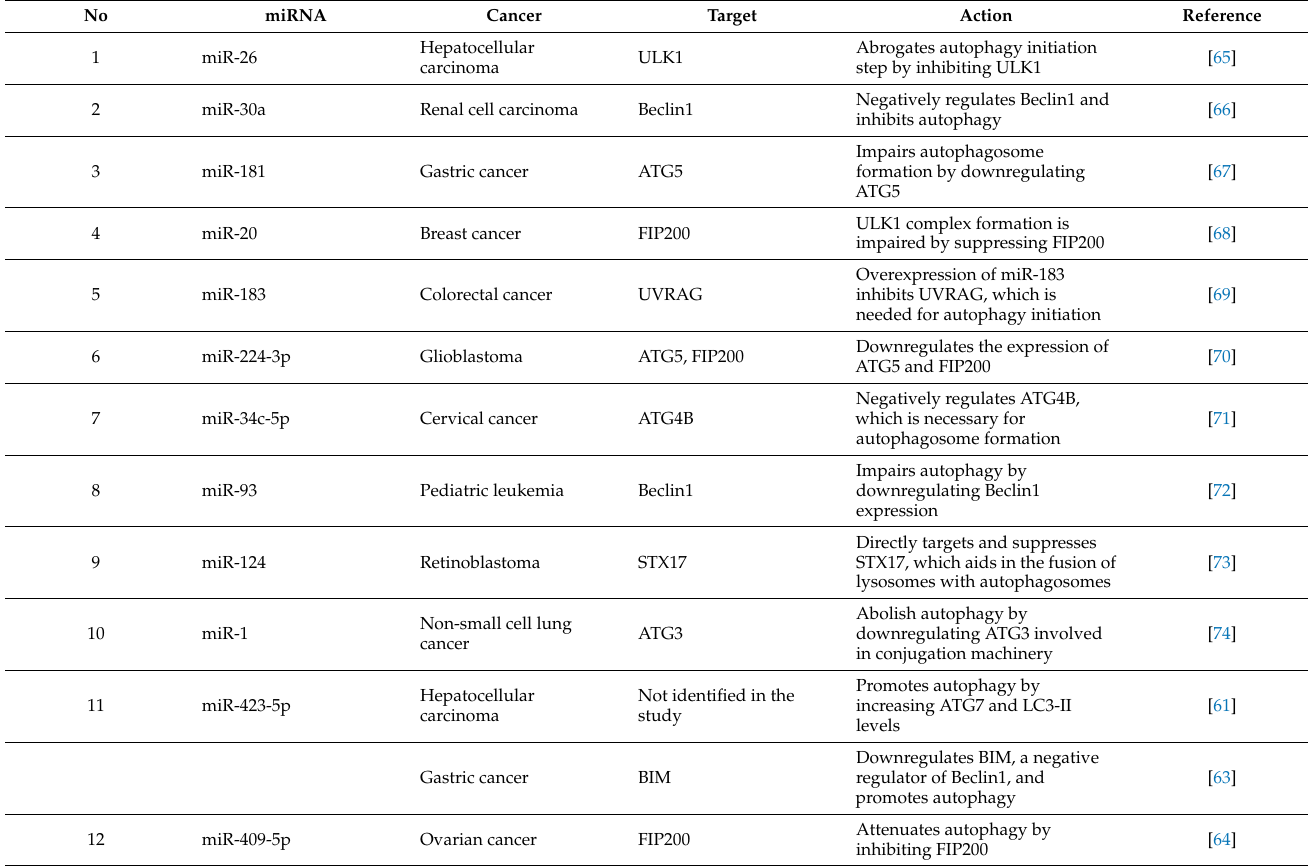
Table 3. The miRNAs implicated in